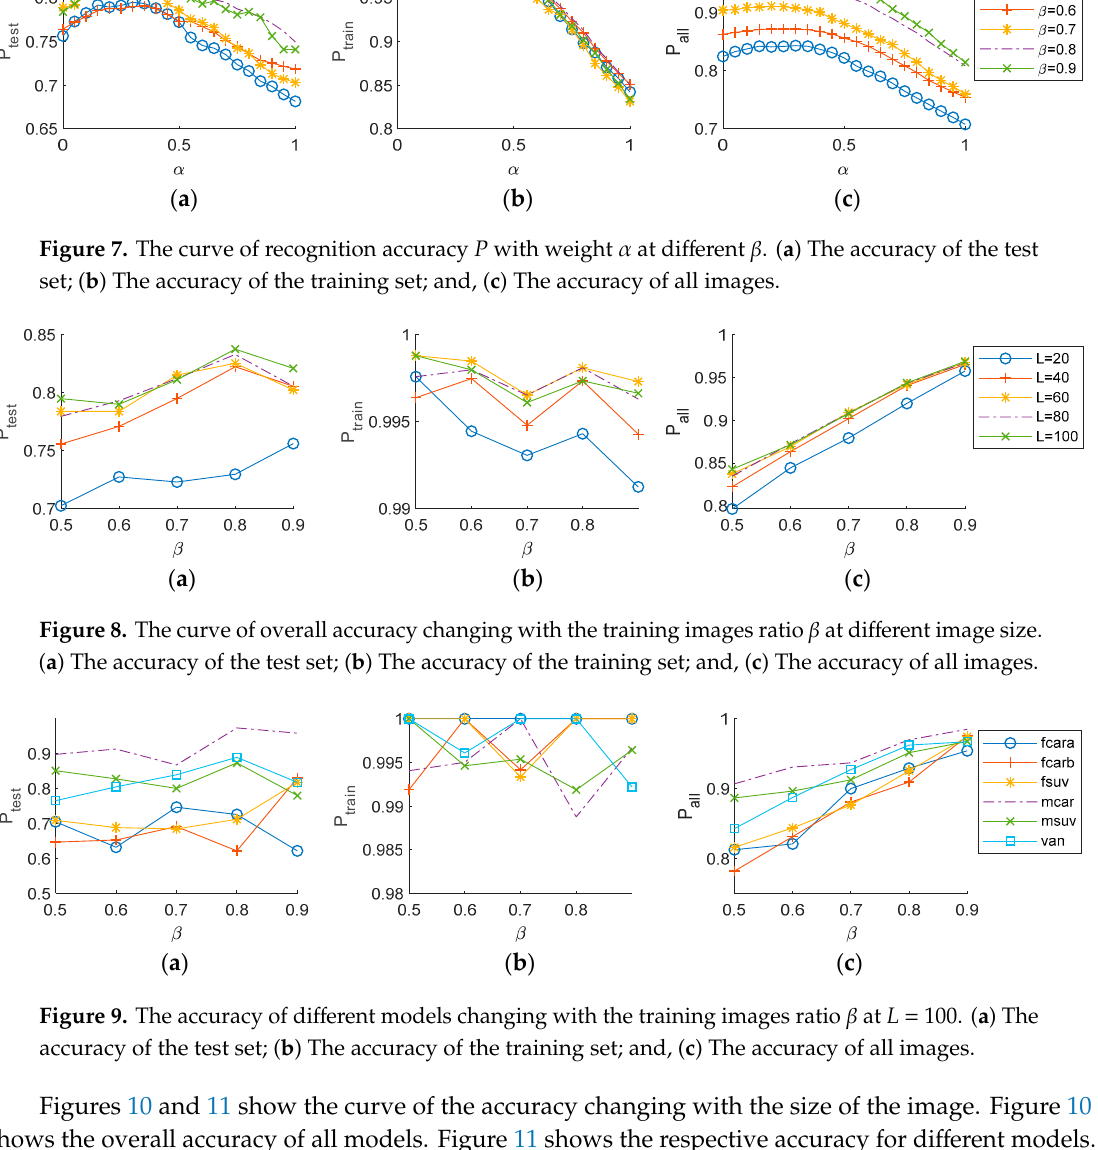
Figure 7. The curve of recognition accuracy P with weight α at different β . ( a ) The accuracy of the test set; ( b ) The accuracy of the training set; and, ( c ) The accuracy of all images. As can be seen from Figure 7a, when α is between 0.2 and 0.4, the proposed algorithm has the